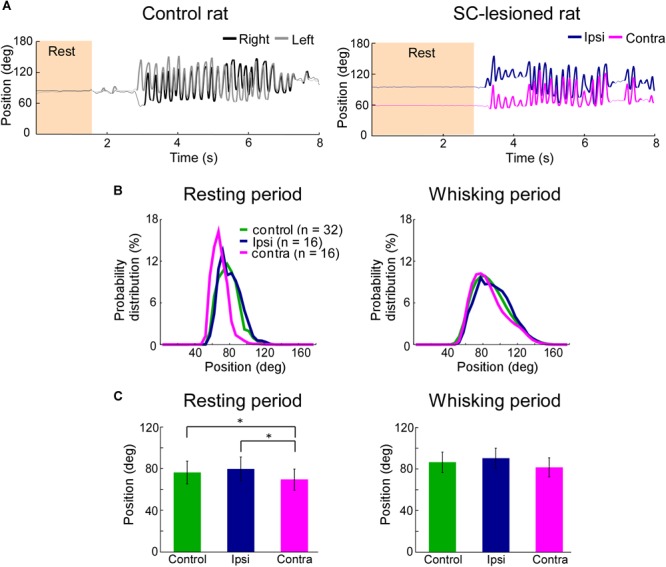
Backward shift of resting vibrissal position on the side contralateral to the lesion. (A) Movements of the right and left C2 vibrissae of a control rat (Left) and a SC-lesioned rat (Right). Examples of resting (shaded region) and whisking (bold trajectory) periods are shown. (B) The distributions of vibrissal positions in resting (Left) and whisking (Right) periods. The medians of the vibrissal position distributions of individual rats in each group (control, ipsi, or contra) are shown. (C) The medians of vibrissal positions of the individual rats were averaged in resting (Left) and whisking (Right) periods. All of the error bars indicate standard deviations. ∗p < 0.05 using Mann–Whitney U-test (control vs. ipsi; control vs. contra) and Wilcoxon ranked-sum test (ipsi vs. contra). SC, superior colliculus; ipsi, side ipsilateral to the lesion; contra, side contralateral to the lesion.